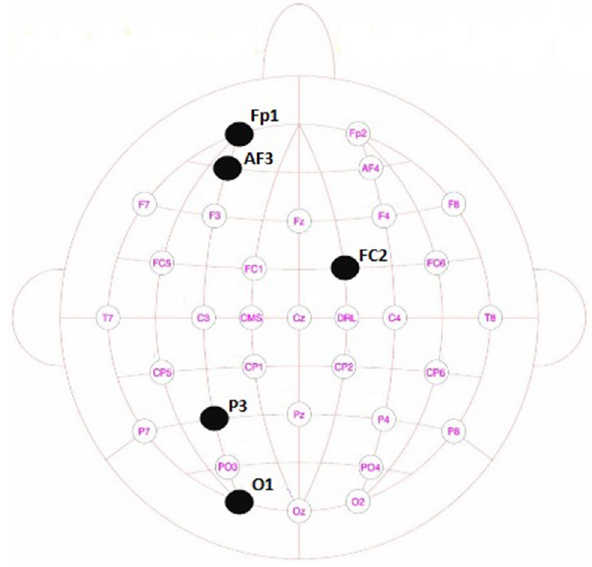
Fig. 7 Positions of five EEG channels having the best classification